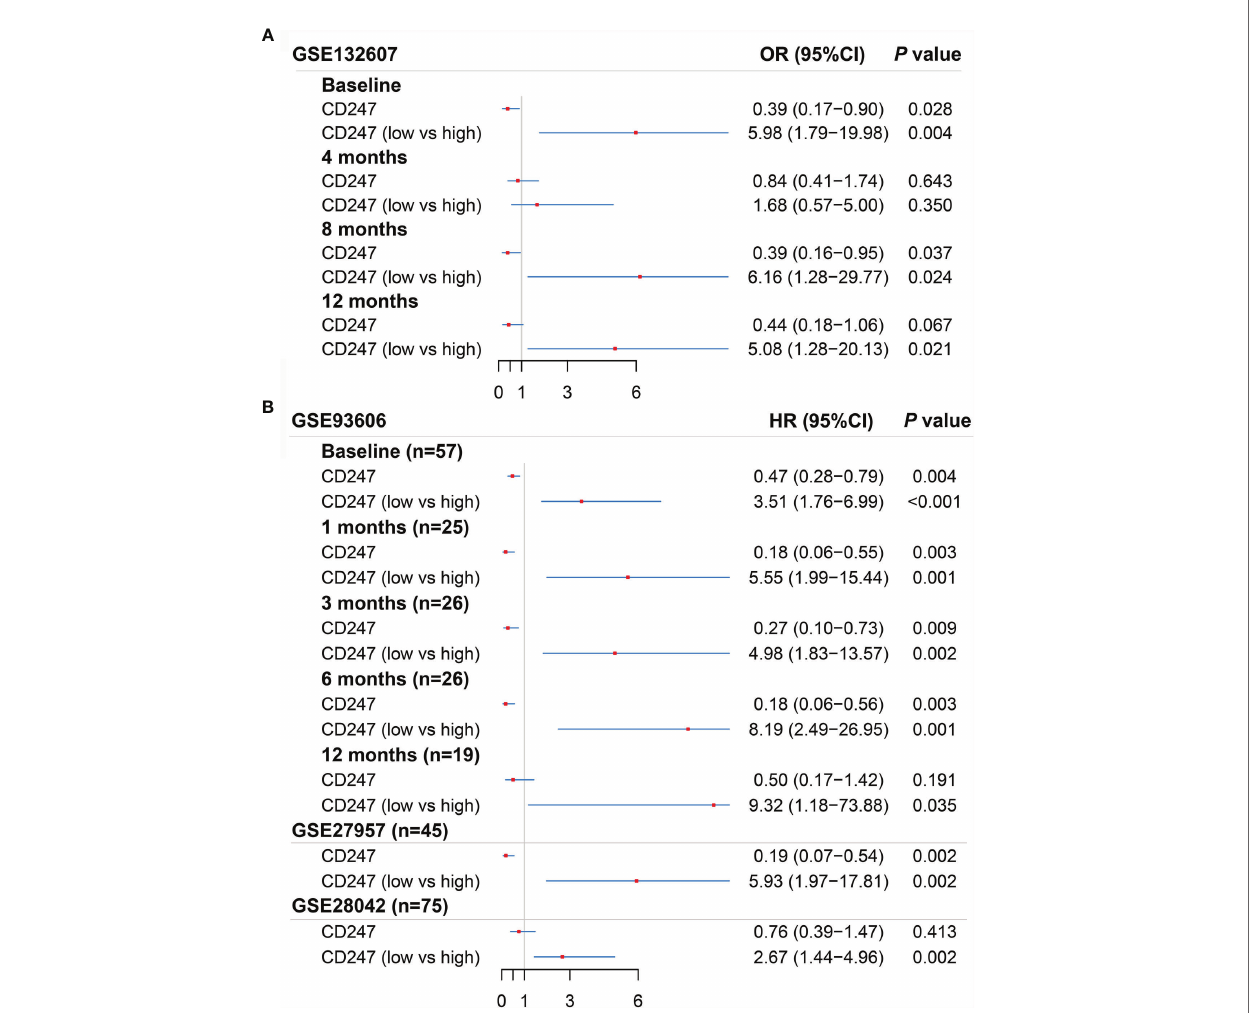
FIGURE 5 | Results of the univariate logistic regression regarding Dlco15 in the GSE132607 dataset (A) and the univariate Cox regression regarding CEP in the GSE93606 dataset and non-TFS in the GSE27957 and GSE28042 datasets (B) . Dlco15, Dlco% predicted decline ≥ 15% over 12 months; TFS, non-transplant-free survival; CEP, composite end point (death or decline in FVC >10% over six months